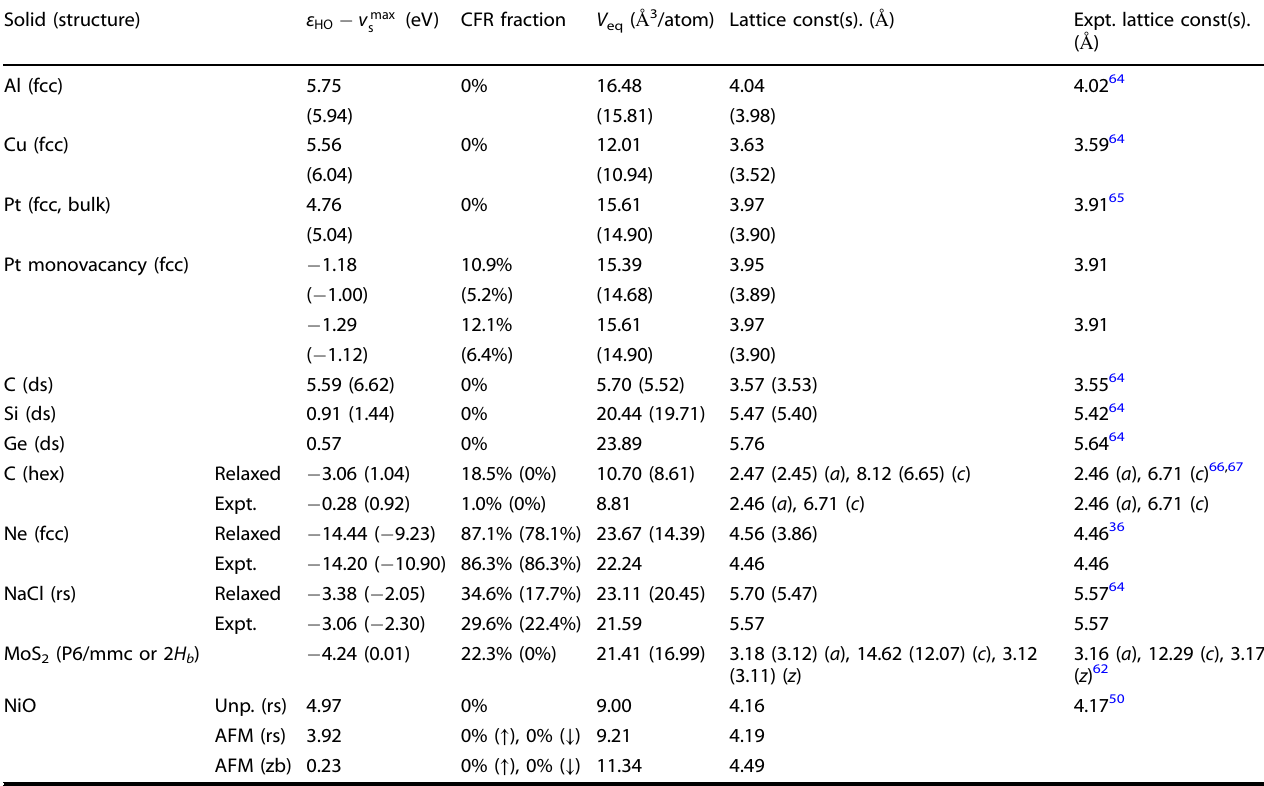
Table 2. Turning surface properties of solids at equilibrium. Solid